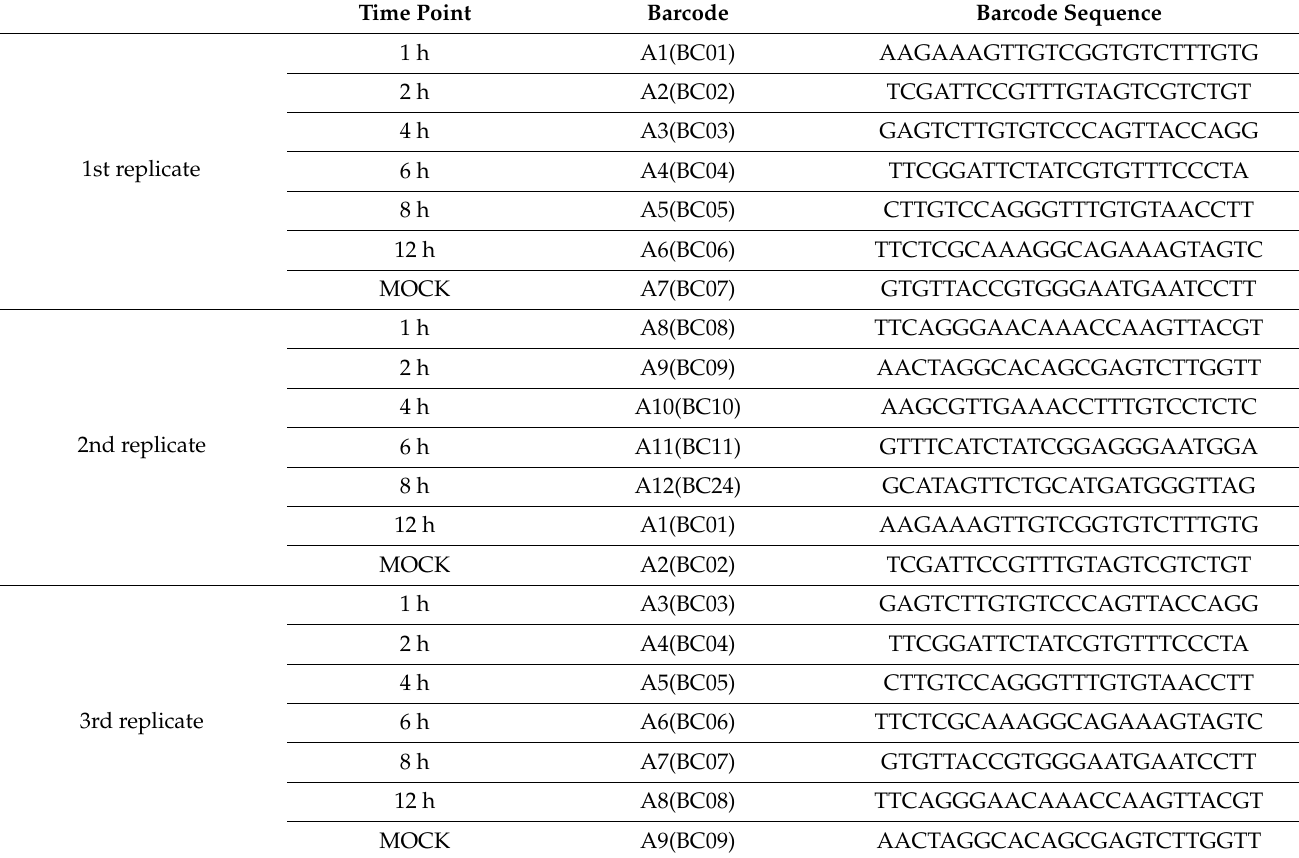
Table 1. Barcode sequences used for labeling the different